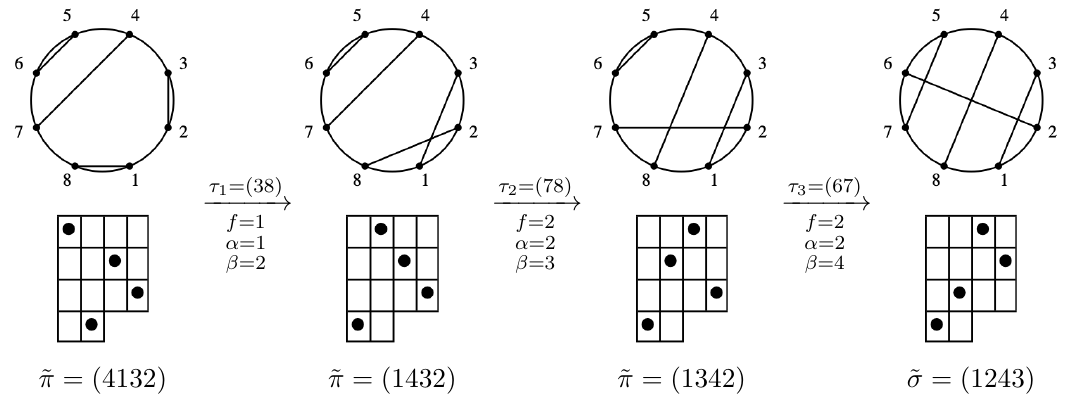
Figure 3 . BCFW construction for writing σ = (13)(26)(48)(57) as σ = τ 3 ◦ τ 2 ◦ τ 1 ◦ σ 0 where σ 0 = (18)(23)(47)(56)